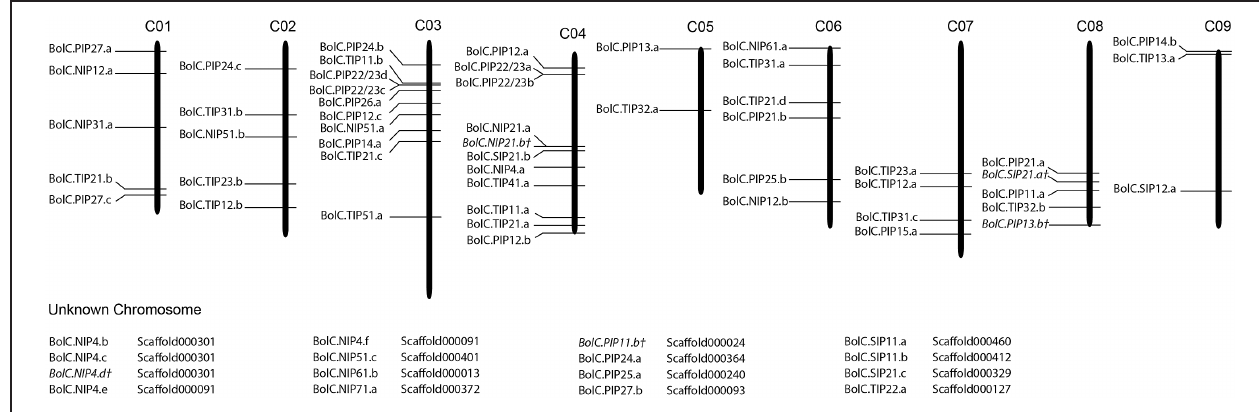
The association to chromosomes (or unanchored scaffolds), their exact position on the latter (manually corrected for the non- satisfactorily annotated AQPs) and the affiliation to each of the three subgenomes and to the blocks of the ancient Brassica kary- otype were determined, listed, and processed ( Tables 1 and 2 ; Figure 1 ). Only one gene ( BolC.NIP51.c ) was not assigned to